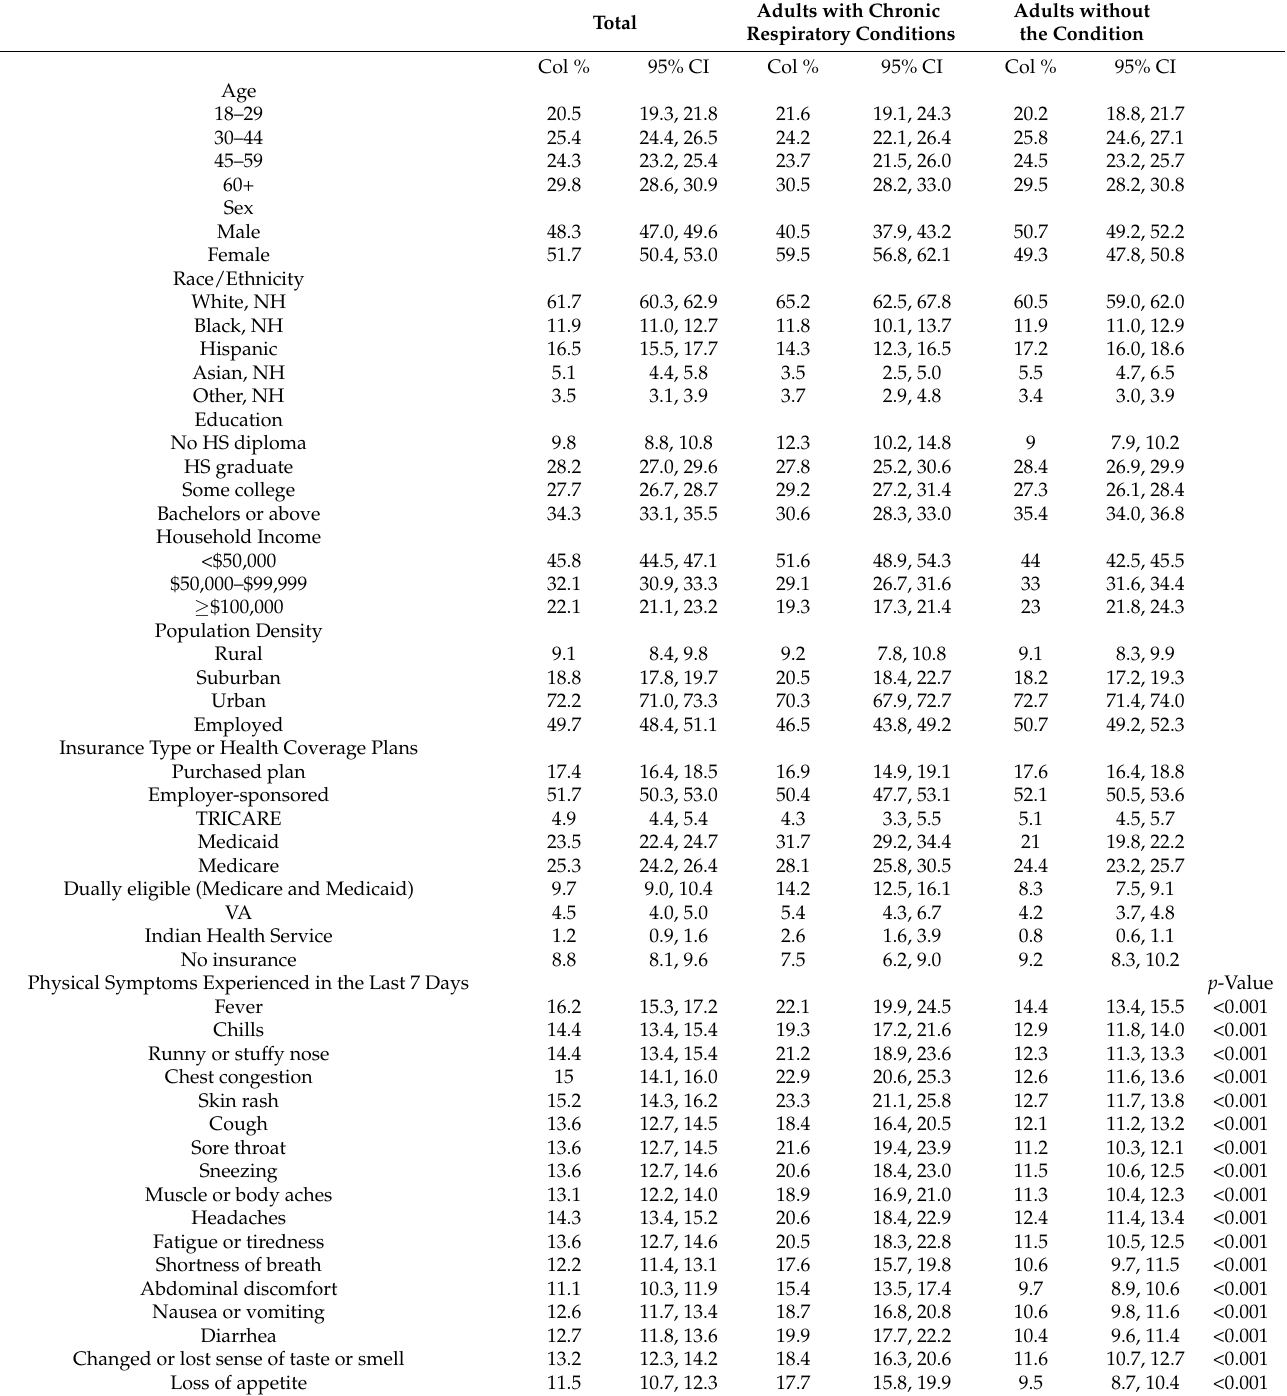
Table 1. Socio-demographic characteristics and reported symptoms among the COVID-19 Impact Survey ( n = 10,760): a nationally representative survey of the US, stratified by respiratory condition diagnosis (April–June 2020). Column percentages (Col %) and 95% confidence intervals (CI) are